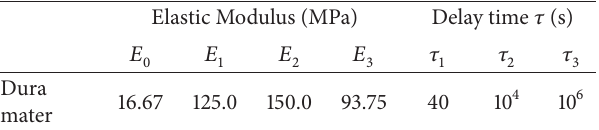
Table 2: Creep coefficients for the viscoelastic properties for fresh human dura